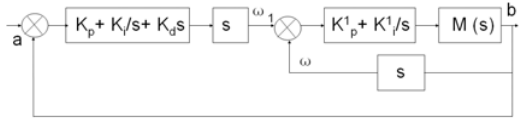
Figure 6. Double closed-loop control block